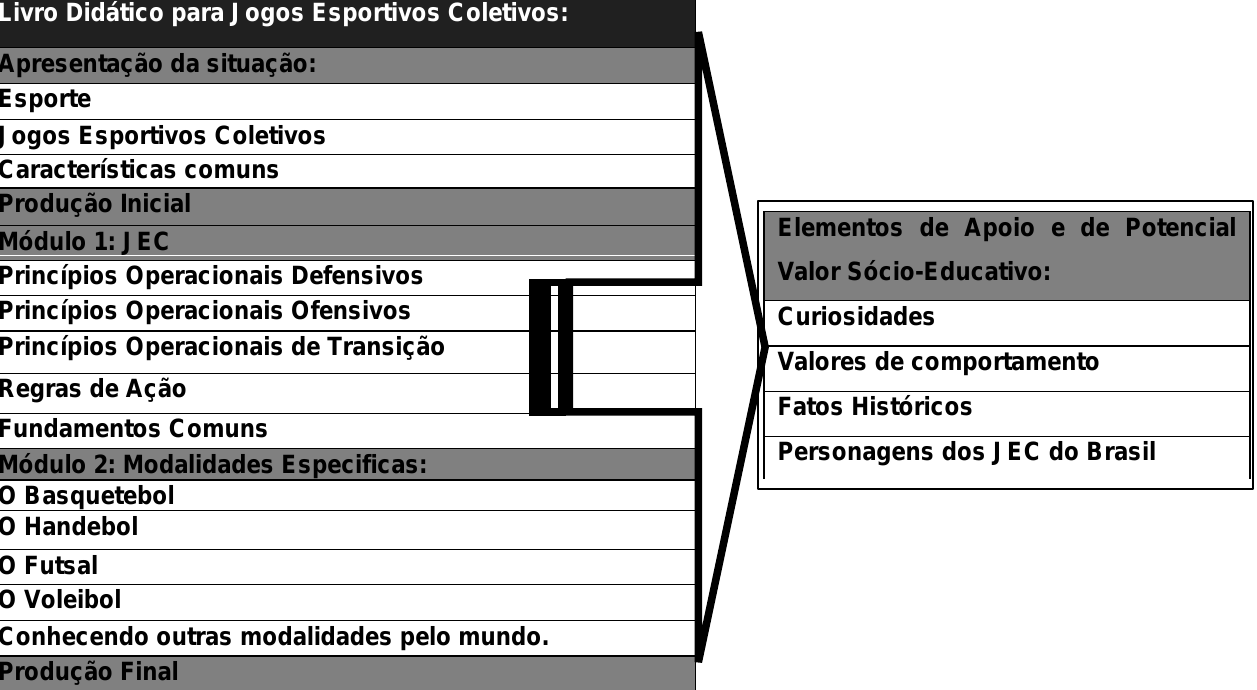
Figura 2. Módulos, Temas e Elementos de Apoio do Livro Didático em Jogos Esportivos Coletivos: a seqüência didática (GALATTI, 2006,